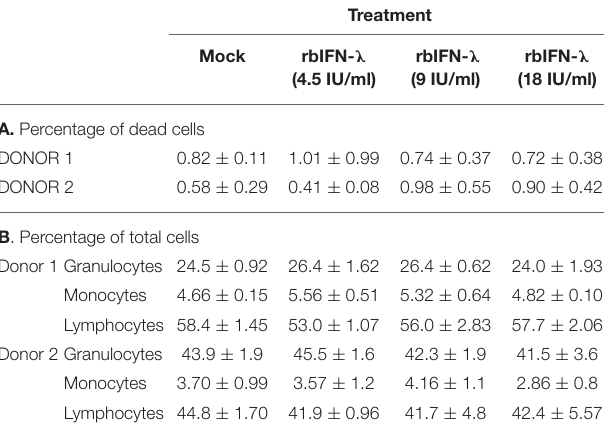
TABLE 3 | Bovine rIFN- λ is safe for human immune cells.